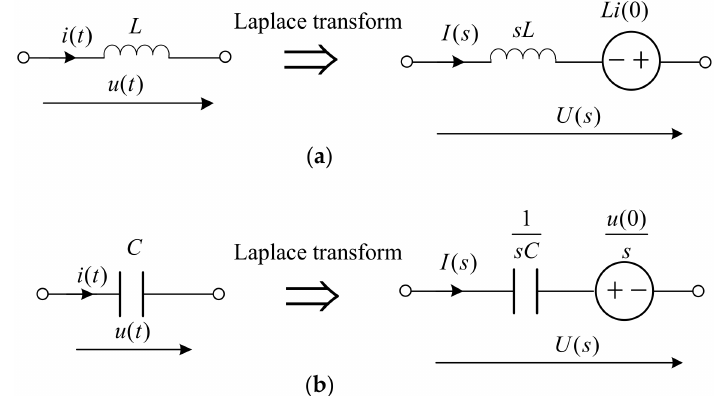
Figure 2. Operation circuit model of basic device. ( a ) Inductor; ( b )